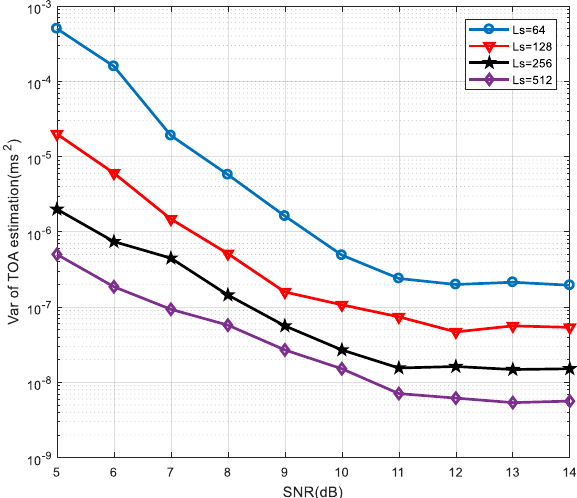
Figure 6. Performance of the TOA estimation.